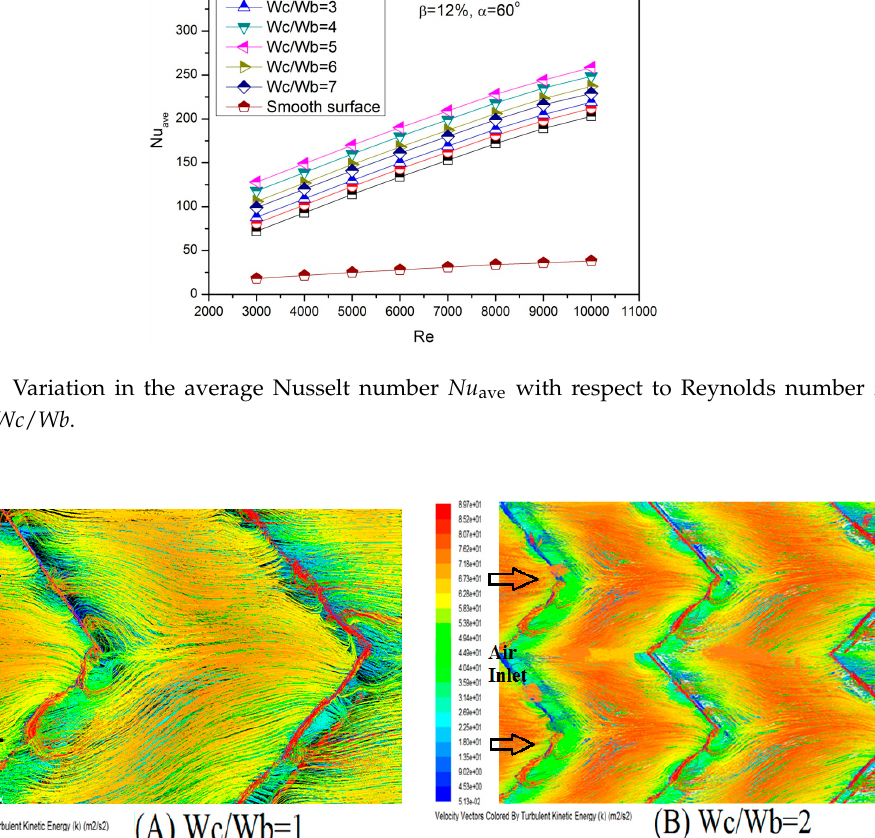
Figure 8. Contour plot of path lines for ( A ) Wc / Wb = 1, ( B ) Wc / Wb = 2, ( C ) Wc / Wb = 3, and ( D ) Wc / Wb = 4 ( e/H = 0.6, P/e = 8.0, O/e = 0.42, β = 12%, α = 60°, and R e = 5000). Use of baffle roughness on a heated wall substantially increases the heat transfer from the heated wall of rectangular channels. However, it results in corresponding increases in frictional losses. Figure 9 shows the variation in the f ave with R e for different values of W c/ Wb , while all other rough parameters are maintained constant at e/H = 0.6, P/e = 8.0, O/e = 0.42, β = 12%, and α = 60°.It has been observed from this plot that the f ave decreases with increases in the R e values, for all values of Wc / Wb . It can also be seen that the f ave increases monotonically with increases in Wc / Wb values. The maximum value of the f ave has been observed at a value of Wc / Wb of 7.0. This is due to fact that angulation of the baffles helps in the development of the secondary stream jets. Increasing the value of Wc / Wb would lead to an increased number of secondary stream jets, which in turn increases the value of the Nu ave up to 5.0. Furthermore, increases in Wc / Wb beyond 5.0 could lead to the partition of flow from the top baffle surface, and to a subsequent reduction in Nu ave . However, the values of f ave increase continuously due to the mixing of an increased number of secondary flows after being issued from the perforations and after their re-attachment with the heated surface. For this reason, this mixing increases heat transfer from the plate to air, but also facilitates large pressure drops through the flow across the passage.